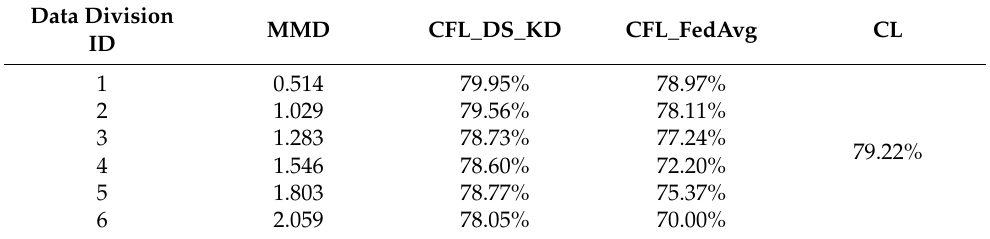
Table 1. The top-1 accuracy of different MMD values on the Alzheimer’s